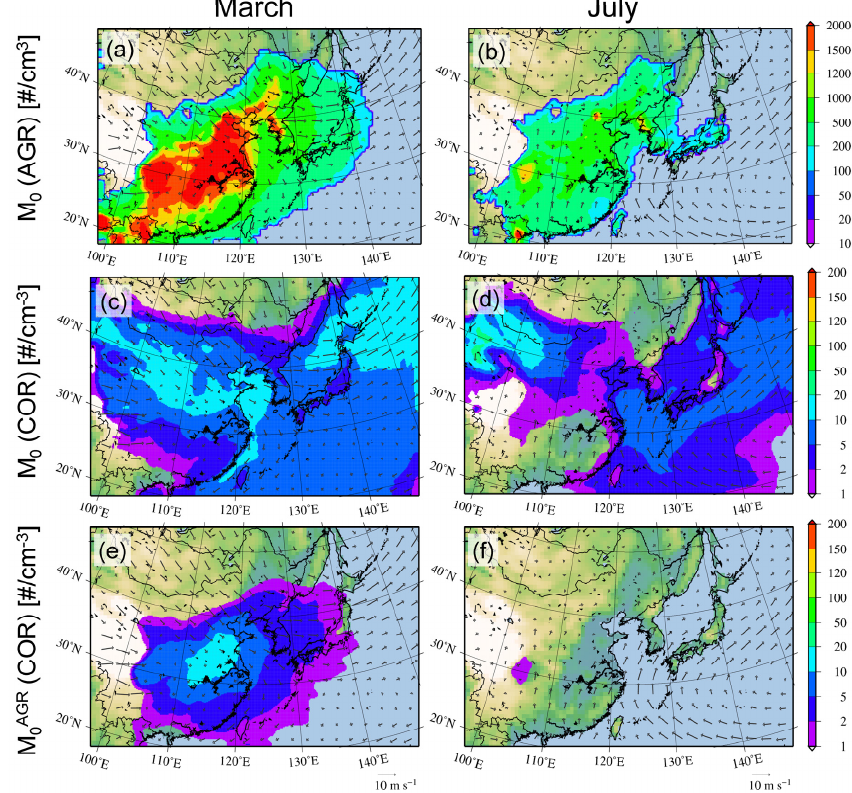
Figure 10. Spatial distributions of mean number concentrations in (left) March and (right) July of (a–b) soot (particlescm − 3 ) , (c–d) coarse mode particles (dust, sea-salt, and anthropogenic PM 10 ) (particlescm − 3 ) and (e–f) the number of soot aggregate particles collided with coarse mode particles (particlescm − 3 ).